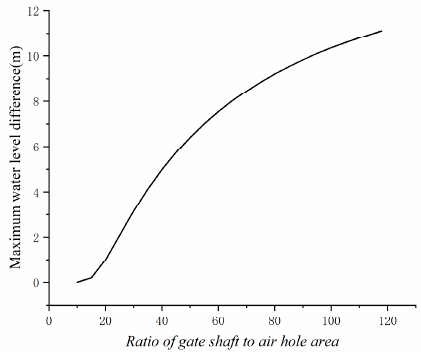
Figure 8. Maximum water level difference between the gate shaft and the air hole with different area ratios.